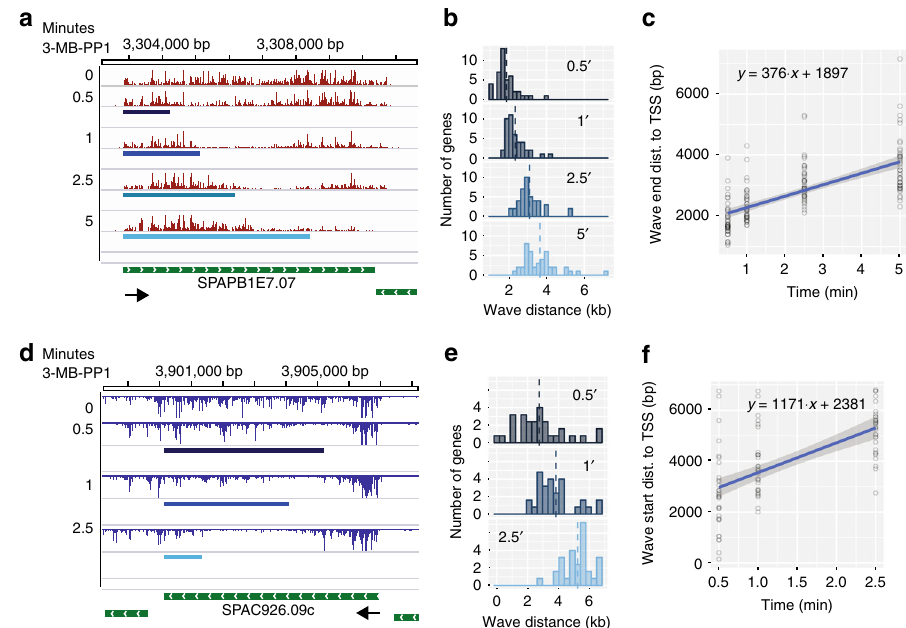
Fig. 4 Distinct effects of Cdk9 inhibition on Pol II rates. a Browser image displaying normalized PRO-seq signal re fl ecting combined data from two biological replicates for increasing lengths of cdk9 as inhibition (top to bottom) over the SPBAPB1E7.07 locus with advancing wave estimates (blue rectangles) for each time point (0.5, 1, 2.5, and 5 min) plotted below the corresponding data. b Histograms of estimated advancing wave end distances (relative to TSS) for fi ltered genes ( n = 43) at each time point after addition of 10 μ M 3-MB-PP1 to cdk9 as cells. Dotted, vertical lines represent the mean distance for each distribution. c Linear regression of distances traveled against time elapsed gives the estimated rate of advancing wave progression (slope). d Browser image showing clearing wave measurements (blue rectangles) for each time point plotted below the corresponding data at the SPAC926.09c locus. e Histograms of estimated clearing wave tail end distances (relative to TSS) for fi ltered genes ( n = 32) at time points (0.5, 1, and 2.5 min) after cdk9 as inhibition. f Linear regression of clearing wave distances traveled vs. time elapsed gives the estimated rate of clearing wave progression